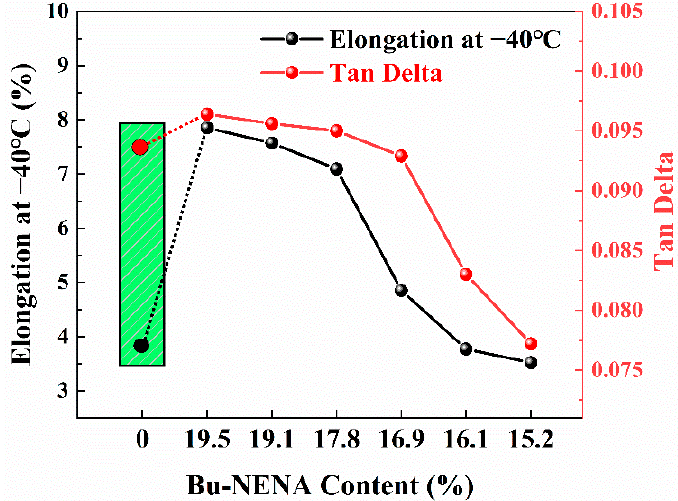
Figure 5. The elongation and Tan δ of R series of propellants.